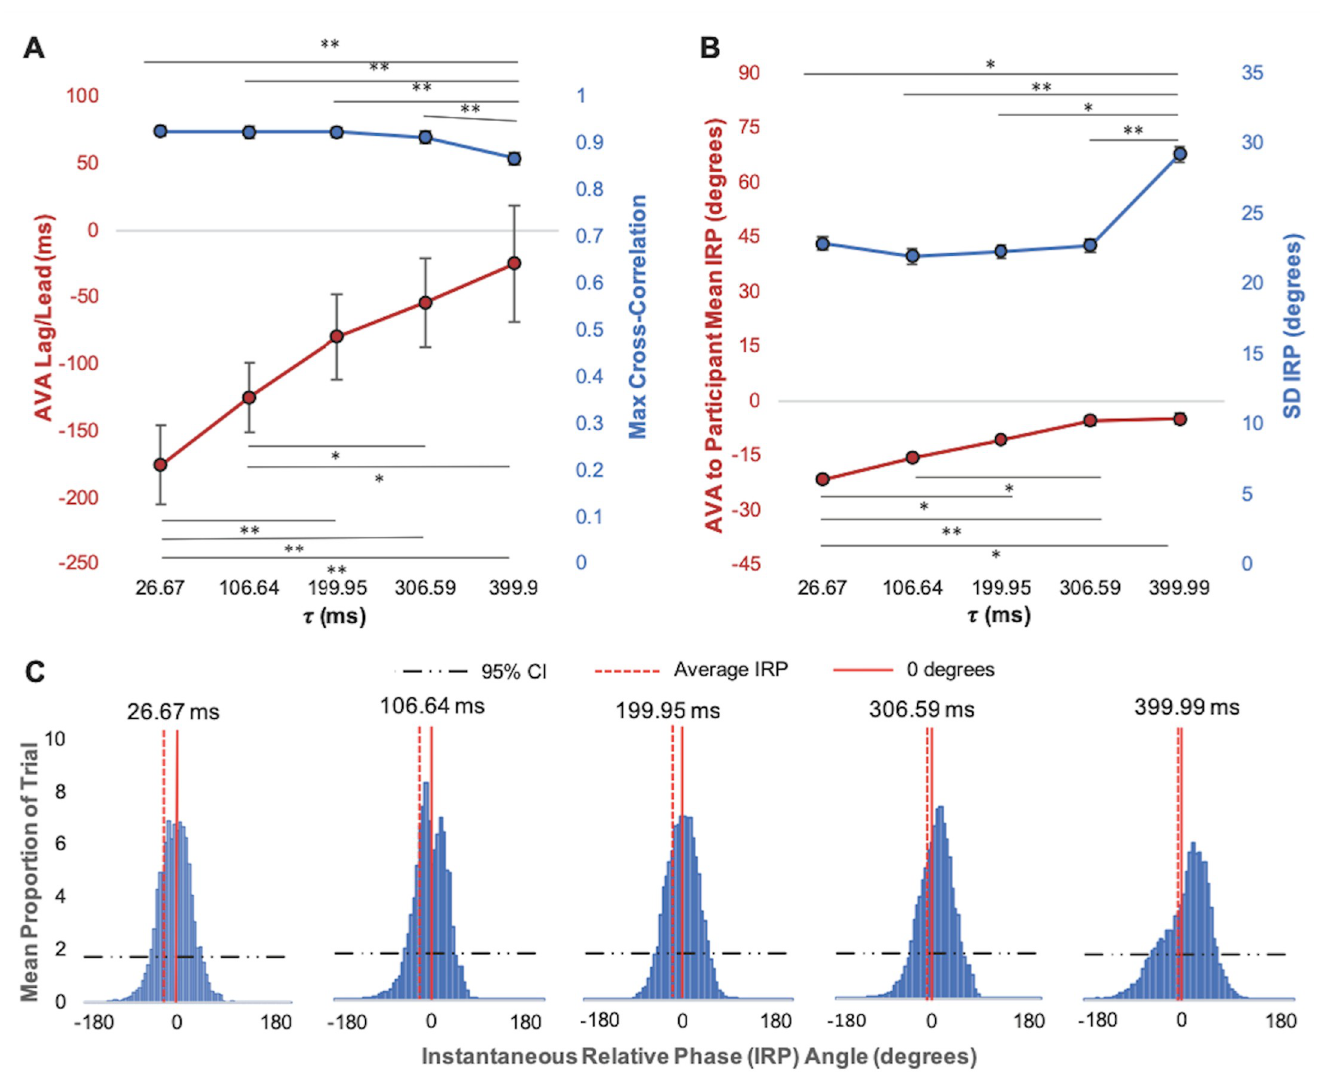
Fig 2. AVA anticipatory synchronization during real-time coordination with a participant- driver . (A) Average maximum cross-correlation (blue) and associated AVA lag/lead (red) and (B) Average IRP (red) and standard deviation of IRP (blue) between AVA- response system and participant- driver movements in each of the feedback delay conditions. Error bars show standard error. � p < .05, �� p < .01. (C) Average IRP distributions between AVA and participant- driver movements for each feedback delay condition. The mean (average) relative phase angle for each condition, as well the cutoff for the 95% CI corresponding to statistically significant a proportion of time spent at a given IRP relationship are also